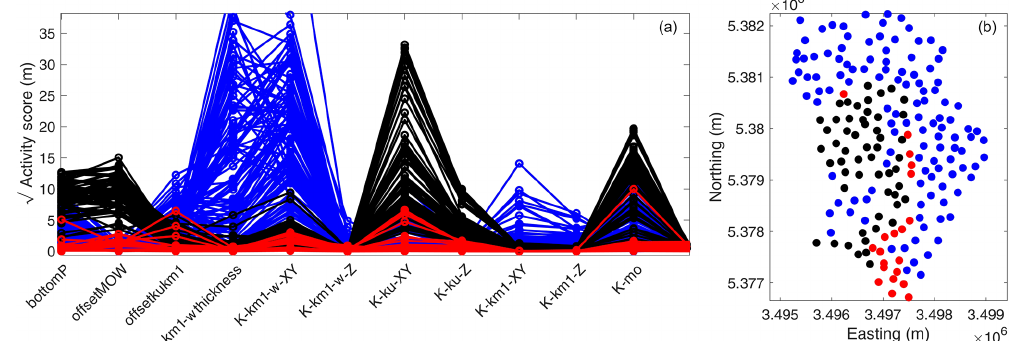
Figure 7. Square root of activity score for 199 wells (a) and their placement in the catchment (b) . Please note that the activity score plot is limited to the 12 most important parameters.